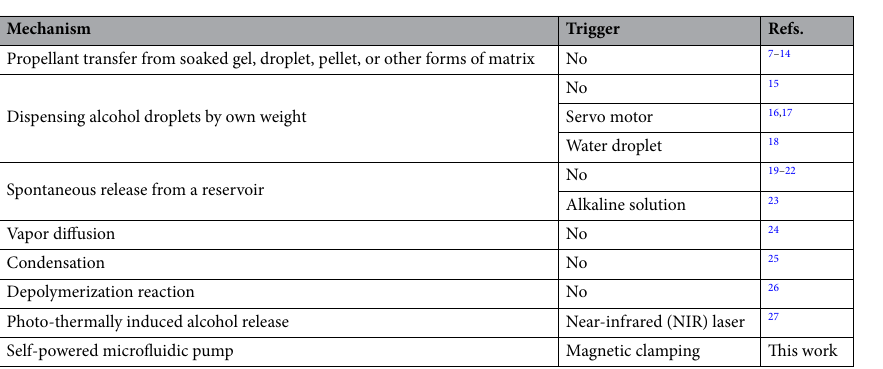
Table 1. State-of-the-art in self-propulsion systems driven by Marangoni effect. Here, no trigger means the self-propulsion started immediately when it was placed on liquid/air interface, or right after filling with